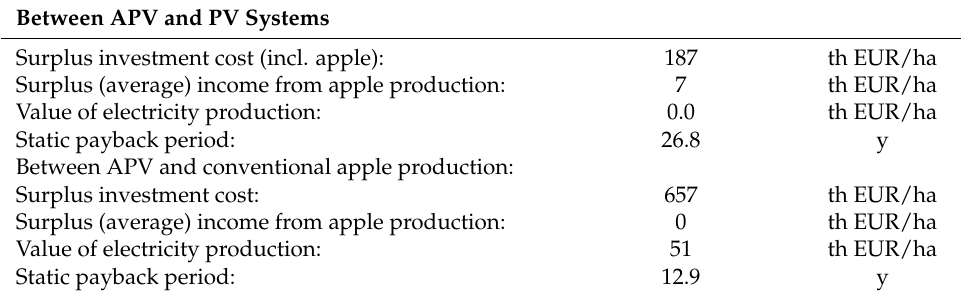
Table 10. Comparative indicators of the economic viability of different production